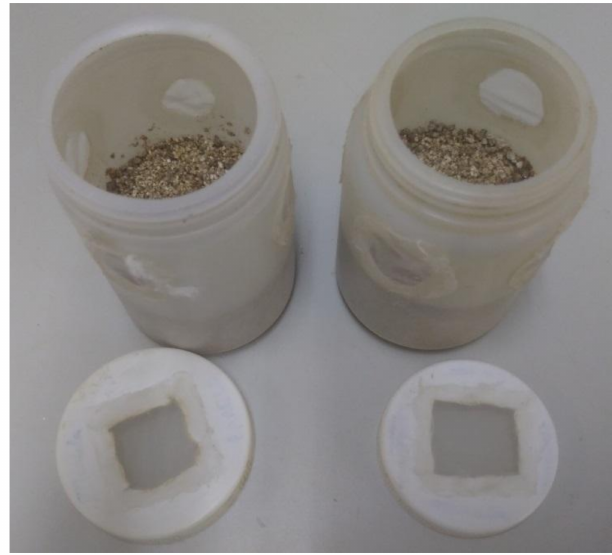
Figure 1. Rearing units (plastic cylinders 12 cm high × 7.5 cm in diameter, volume ca. 500 mL) with five holes in the wall of the upper half, closed with polyester mesh of 0.2 mm openings, to allow ventilation. Each unit was half filled with